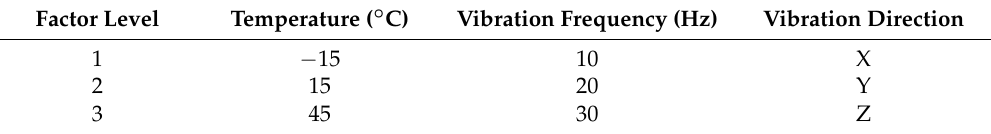
Table 11. The levels of all